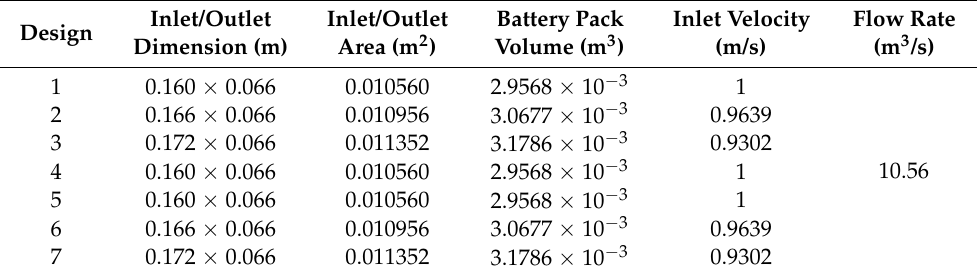
Table 3. Different inlet and outlet dimensions and inlet velocities to deliver the same flow rate (10.56 × 10 − 3 m 3